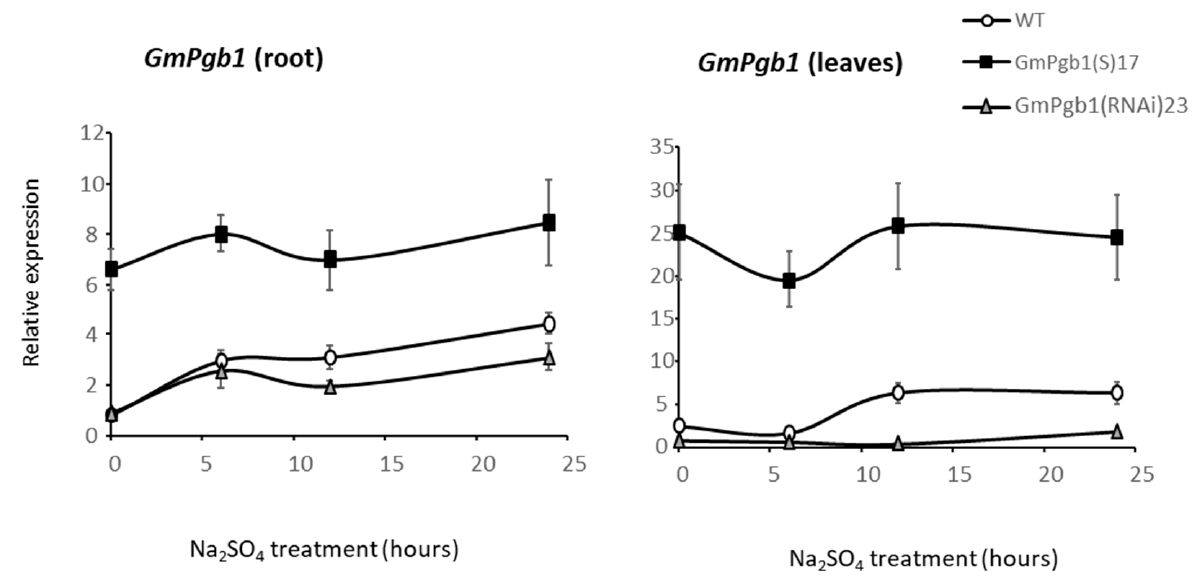
Figure 1. Expression level of GmPgb1 in roots and leaves of soybean plants exposed to Na 2 SO 4 for 24 h. Measurements were taken in the WT line and lines overexpressing (GmPgb1(S)17) or downregulating (GmPgb1(RNAi)23) GmPgb1 . Values are the means + SE of three biological replicates, each consisting of at least three plants.